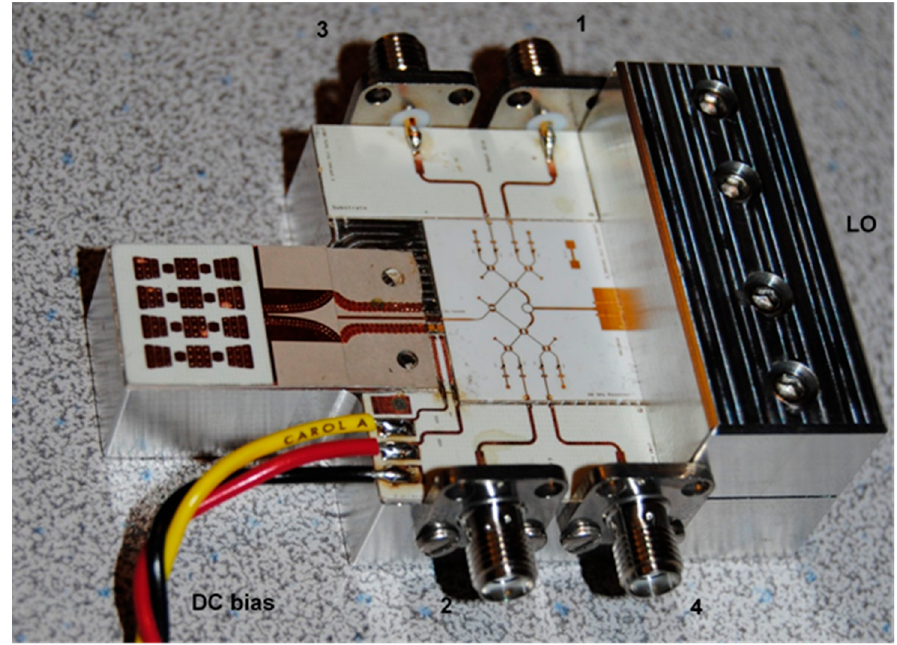
Figure 20. V-band front-end with MMIC LNA in-between two separate MHMICs: overall view.